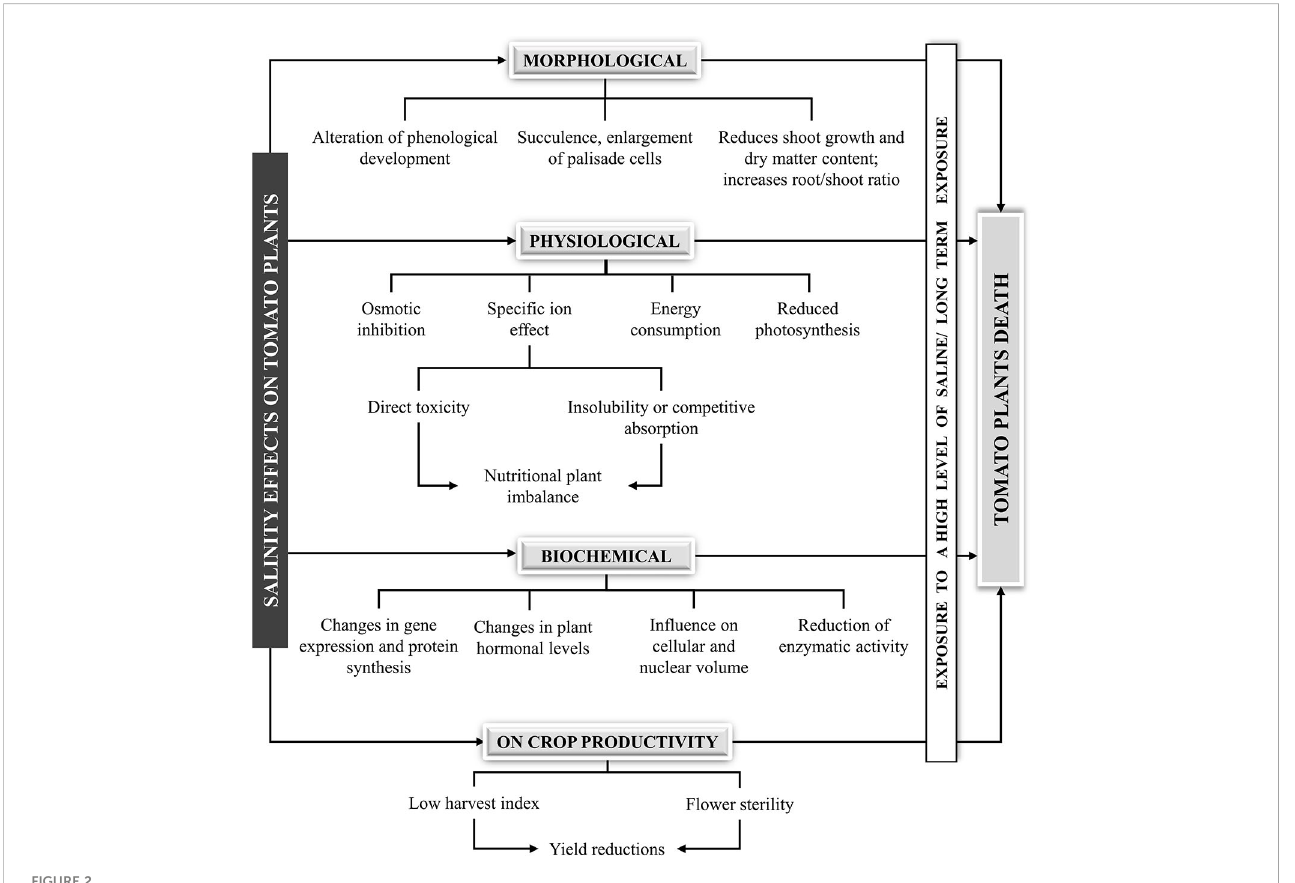
FIGURE 2 Salinity effects on tomato